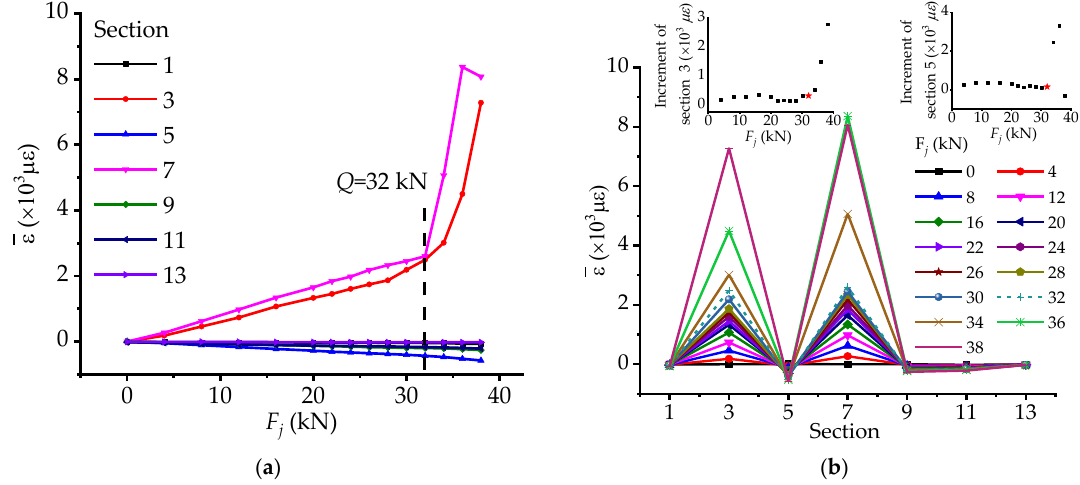
Figure 10. The changing features of generalized axial force stressing state modes: ( a ) The trend changing features of generalized axial force stressing state mode; ( b ) The distribution pattern changing features of generalized axial force stressing state mode.